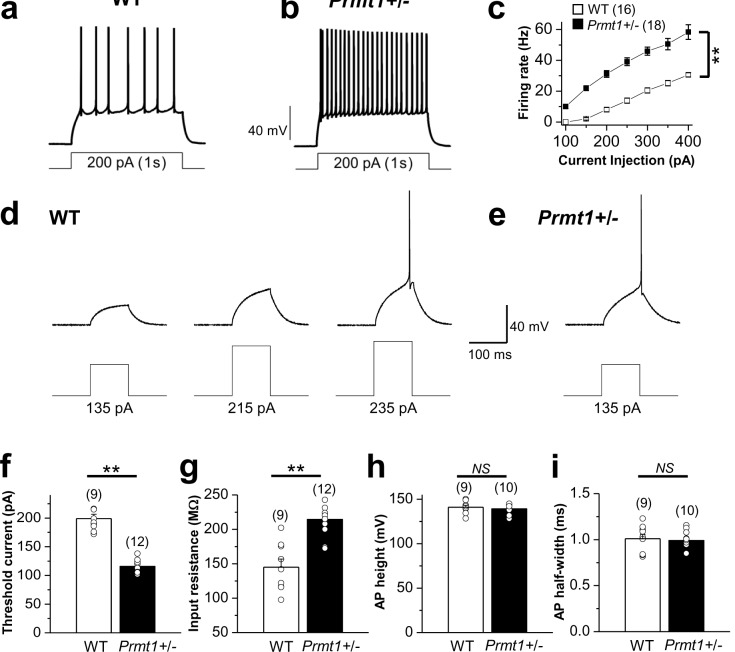
Comparison of neuronal excitability in WT and Prmt1+/- mice.(a–b) a and b panels show representative trace in the whole-cell current-clamp recording from WT (a) and Prmt1+/- (b) mature dentate GCs in response to 1-s depolarizing current injection (200 pA), respectively. (c) the mean number of action potentials (AP No.) plotted against the eliciting currents (from 100 pA to 400 pA, + 50 pA increment, during 1-s). At all amplitudes, the Mean ± S.E.M. AP No. is significantly higher in Prmt1+/- (■; n = 18, seven mice) than WT dentate GCs (□; n = 16, seven mice; p<0.01). (d–e) the threshold current for single AP elicited by a short depolarizing (100 ms) step pulse of various amplitude in WT (d) and Prmt1+/- (e) dentate GCs. (f–i) the mean value of threshold current for AP generation (100 ms duration; f), input resistance (g), AP height (h), and AP half-width (i) from WT and Prmt1+/- mature dentate GCs.DOI:
http://dx.doi.org/10.7554/eLife.17159.00510.7554/eLife.17159.006Figure 2—source data 1.Source data for Figure 2.